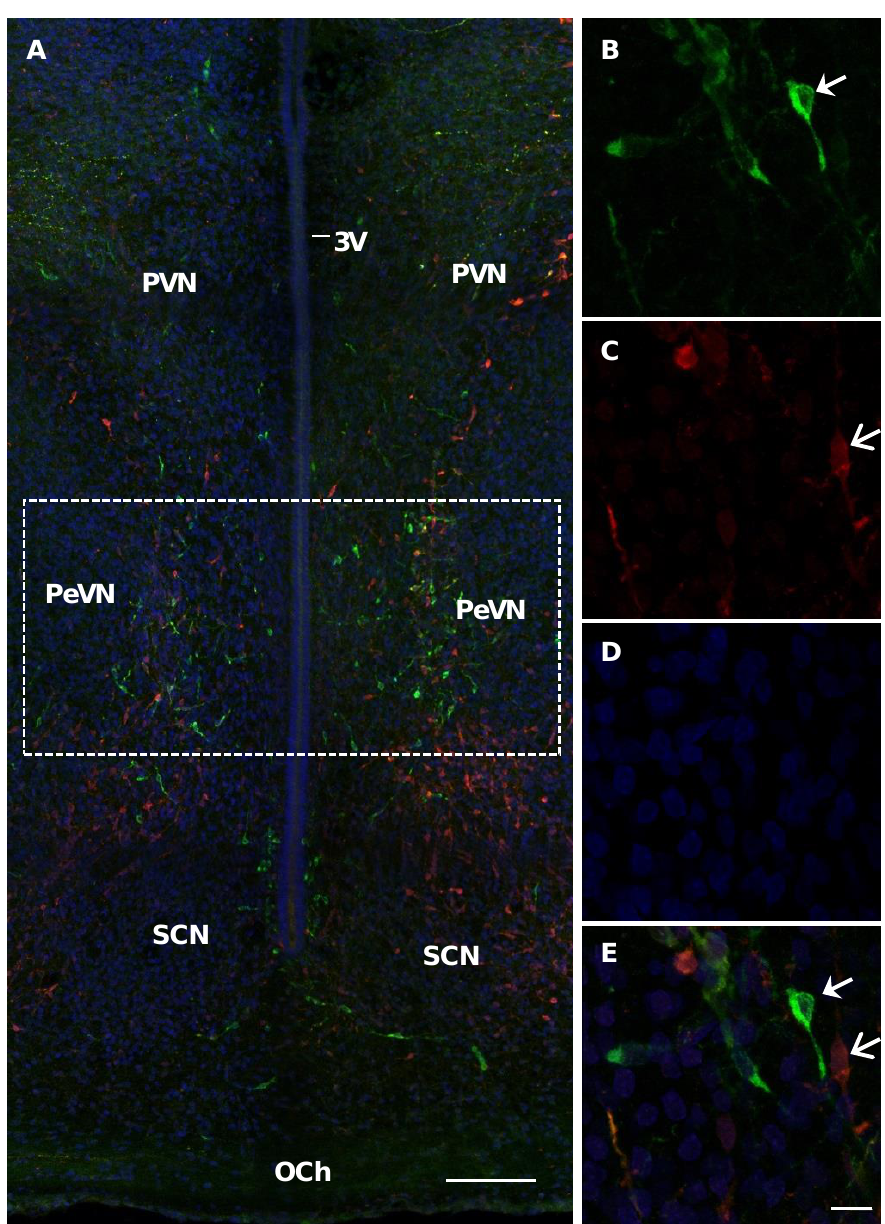
Figure 4. Confocal microscopy of the periventricular nucleus (PeVN) (frontal sections) of the rat on embryonic day 21. ( A ), general view of the PeVN (dotted frame) with neurons, immunopositive for either tyrosine hydroxylase (TH, green) or aromatic L-amino acid decarboxylase (AADC) (red). ( A , B , E ), neurons, immunopositive for TH, but immunonegative for AADC (green, arrow); ( C , E ), immunopositive for AADC, but immunonegative for TH (red, open arrow); ( A ), immunopositive for both enzymes (yellow). ( D ), cells with nuclei stained with DAPI (blue). 3V, 3rd cerebral ventricle; OCh, optic chiasma; PVN, paraventricular nucleus; SCN, suprachiasmatic nucleus. Bar: A — 100 µm, ( B – E ) — 10 µm.